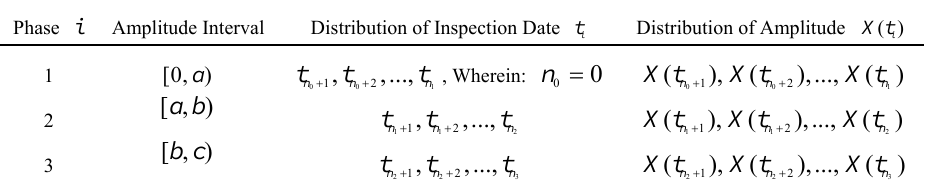
Figure 4 Steps to Establish the Multi-stage Linear Fitting Model Table 10 Distribution of Amplitude and Inspection Time Series in Different Stages of